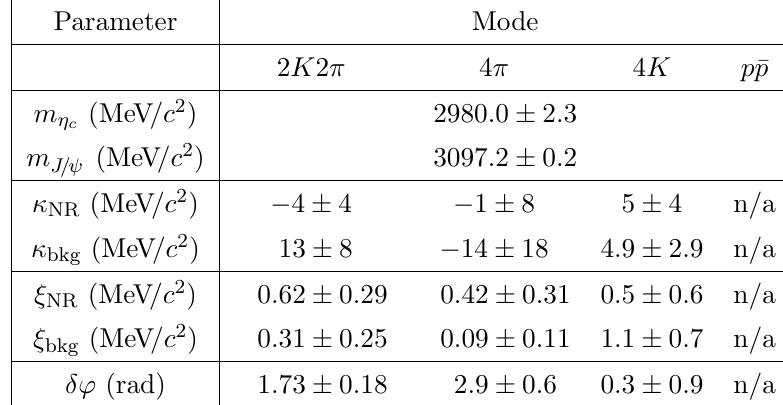
Table 4 . Result of the simultaneous (cid:12)t to the p (cid:22) p and 4 h invariant-mass spectra. Uncertainties are statistical only. The J= and (cid:17) c magnitudes do not appear since they are set to unity as reference and parametrised as a function of B ( B 0 ! (cid:17) c (cid:30) ), respectively. In the simultaneous (cid:12)t, the m (cid:17) s m parameters are shared across the four modes. The measured value of B ( B 0 J= in eq. (7.2). The abbreviation \n/a" stands for \not